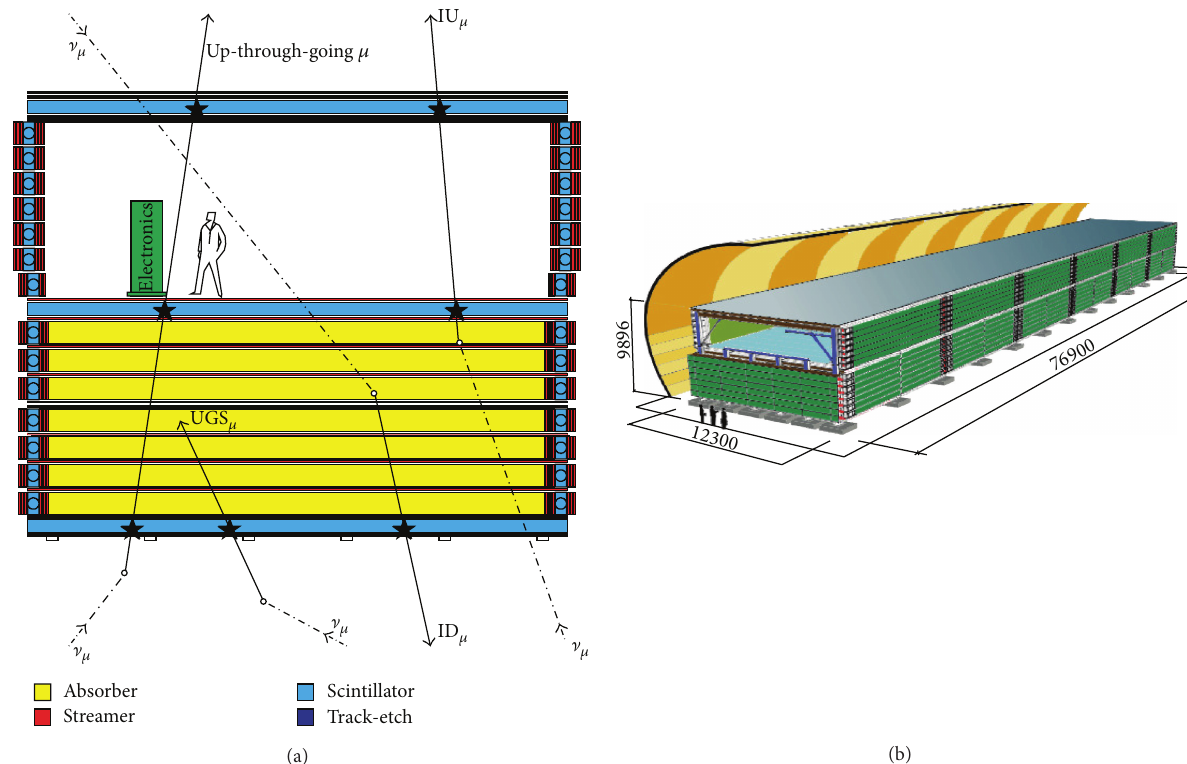
Figure 3: Cross section (a) and global view (b) of the MACRO detector. In the left figure are also shown the observed neutrino-induced event topologies.